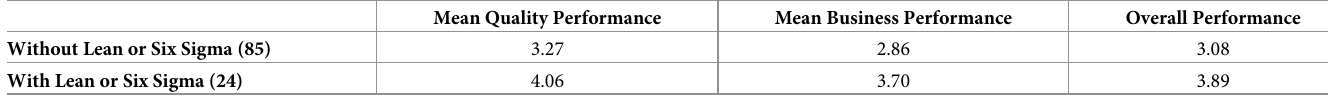
Table 12. Comparison of performance of hospitals with and without Lean or Six Sigma.